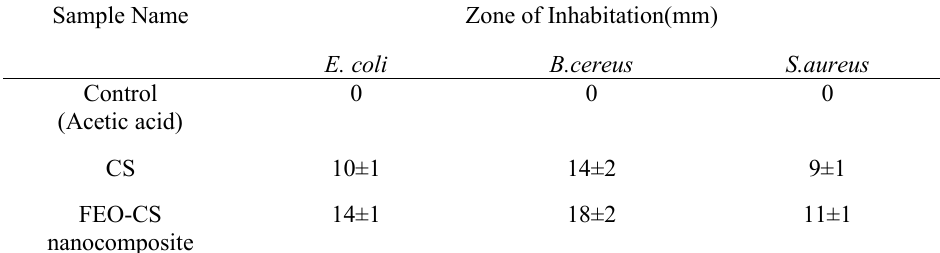
Table 1. Obtained results of the antibacterial test (agar well diffusion assay